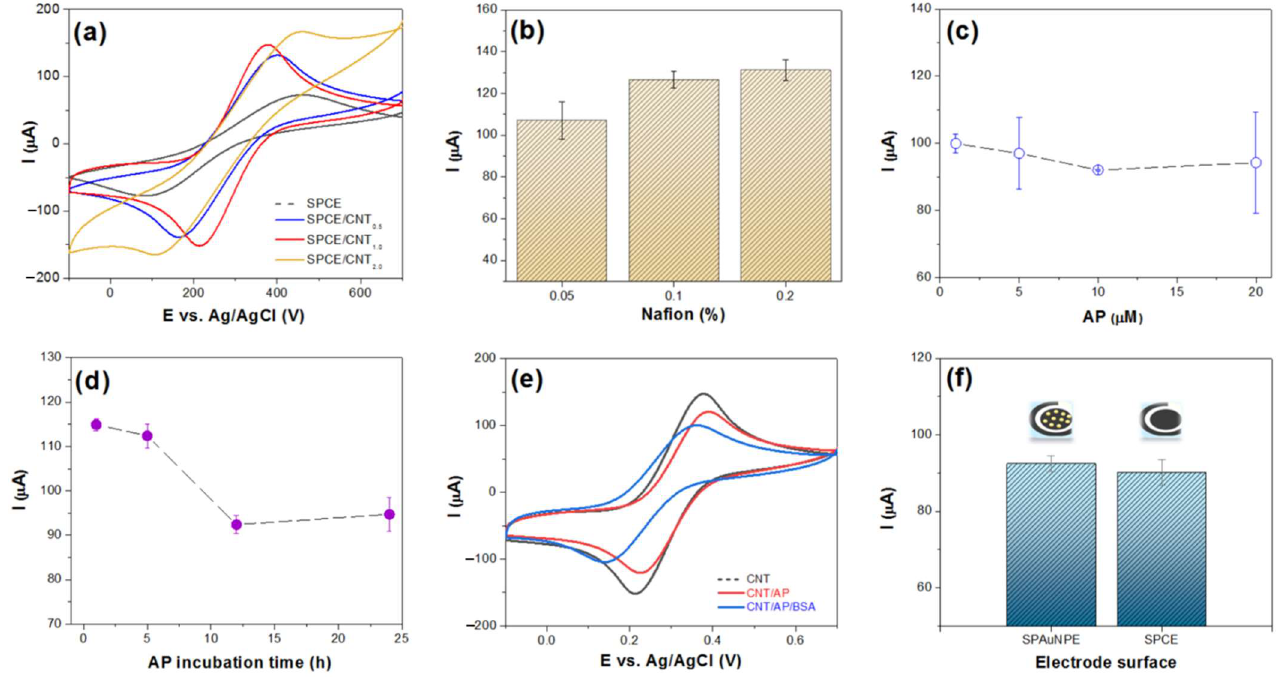
Figure 1. Optimization of the variables in the fabrication of the aptasensor in 5.0 mM (Fe(CN) 6 ) 4−/3− in 0.1 M PBS + 0.1 M KCl (pH 7.4): ( a ) cyclic voltammograms of bare SPCE and modified SCPE with different concentration of CNT; ( b ) concentration of Nafion in 1.0 mg/mL dispersion with CNT; ( c ) aptamer concentration; ( d ) incubation time of 10.0 µM of aptamer; ( e ) presence/absence of BSA, and ( f ) different electrodes surfaces used as support . All measurements were performed in triplicate.